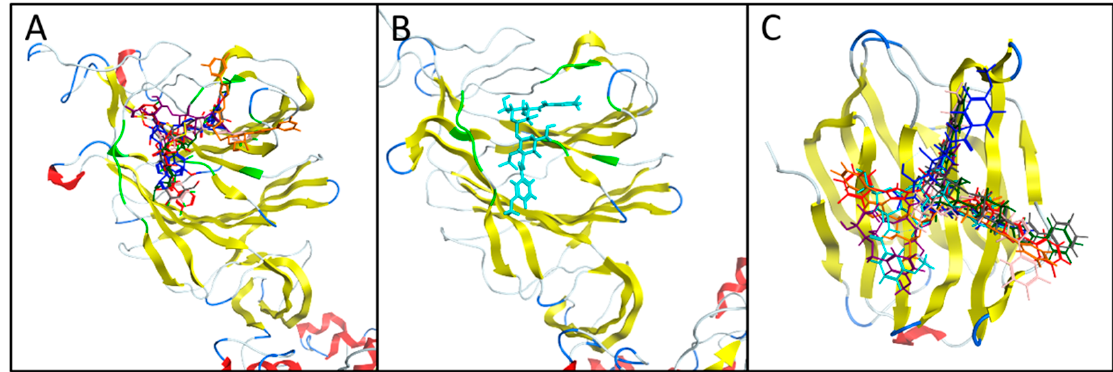
Figure 6. Binding poses of ( A ) A6J (dark-blue), NEW8 (orange), 8VT (purple) and TD2 (red), NEW7 (pink), NEW5 (dark green) and p8G (dark grey) on ( A ) S1-NTD domain open conformation, ( B ) GMK (cyan) on S1-NTD domain closed conformation, and ( C ) binding poses of on Gal-3 with the same colour codes mentioned in ( A , B ) parts except NEW6 (dark gray), NEW4 (pink) and NEW1(dark green). The site 4 (sialoside site) residues are highlighted in light green.